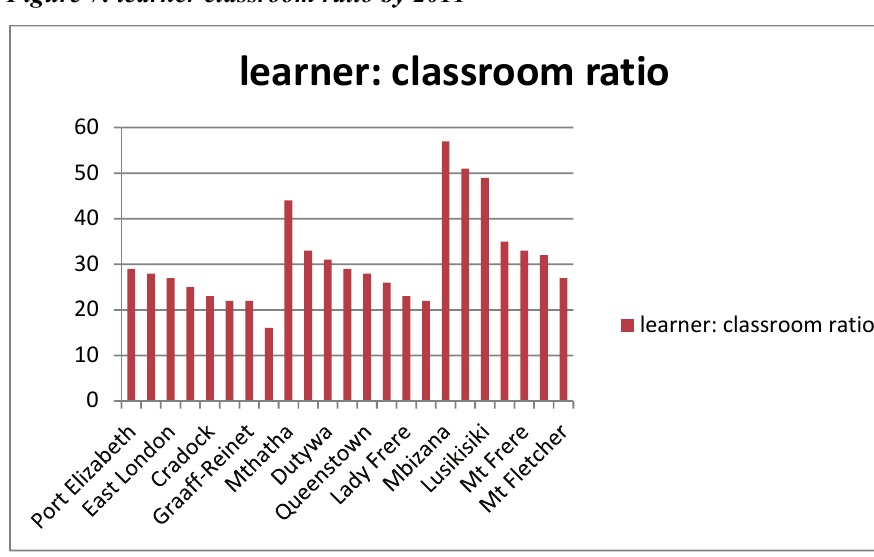
Figure 7: learner classroom ratio by